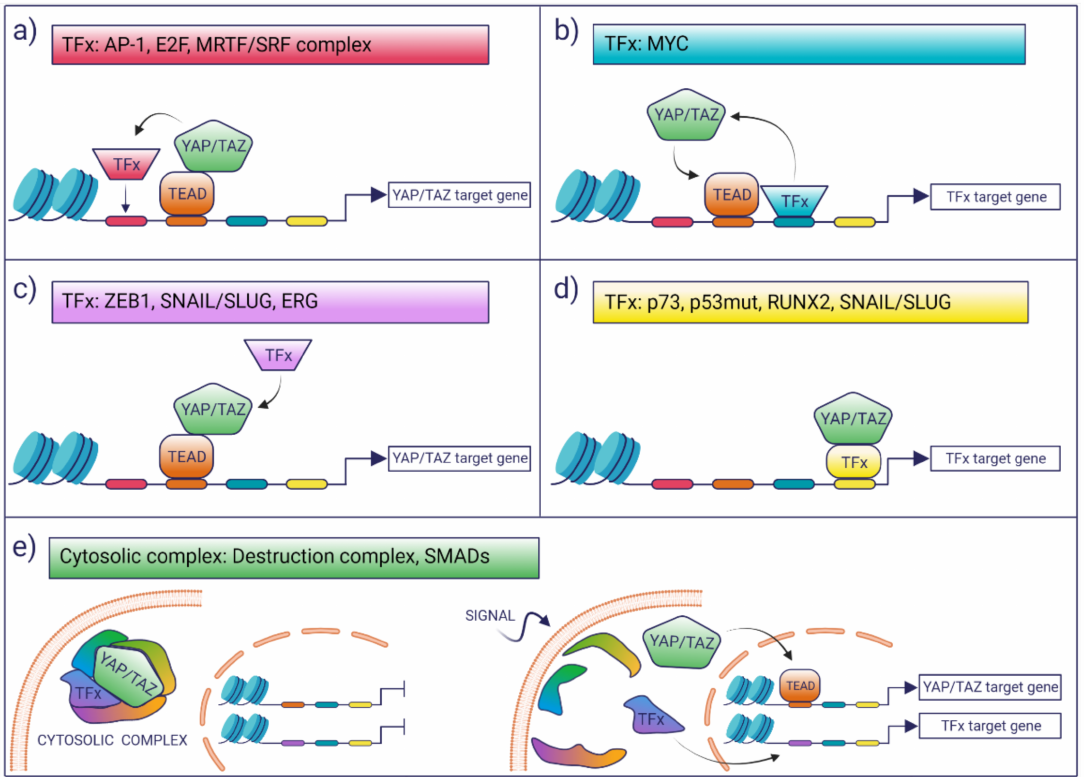
Figure 1. YAP/TAZ orchestrate transcriptional control by interacting with other transcription factors (TFs). A schematic overview of the general mechanisms by which YAP/TAZ can integrate with other transcription factors in order to modulate complex transcriptional responses. ( a ) Regulation of YAP/TAZ targets by cis interactions with other TFs; ( b ) regulation of other TFs targets by YAP/TAZ; ( c ) regulation of YAZ/TAZ activity on their targets mediated only by protein–protein chromatin-associated complexes; ( d ) modulation of other TFs activity, on their respective targets, mediated only by protein– protein chromatin-associated complexes; ( e ) modulation based on non-nuclear protein–protein interaction. Please note that although DNA regulatory elements have been placed near the transcribed genes, it is implied that these modes of regulation apply to both promoters and enhancers. Created with BioRender.com. (https://help.biorender.com/en/articles/3619405- how-do-i-cite-biorender, accessed on 23 July